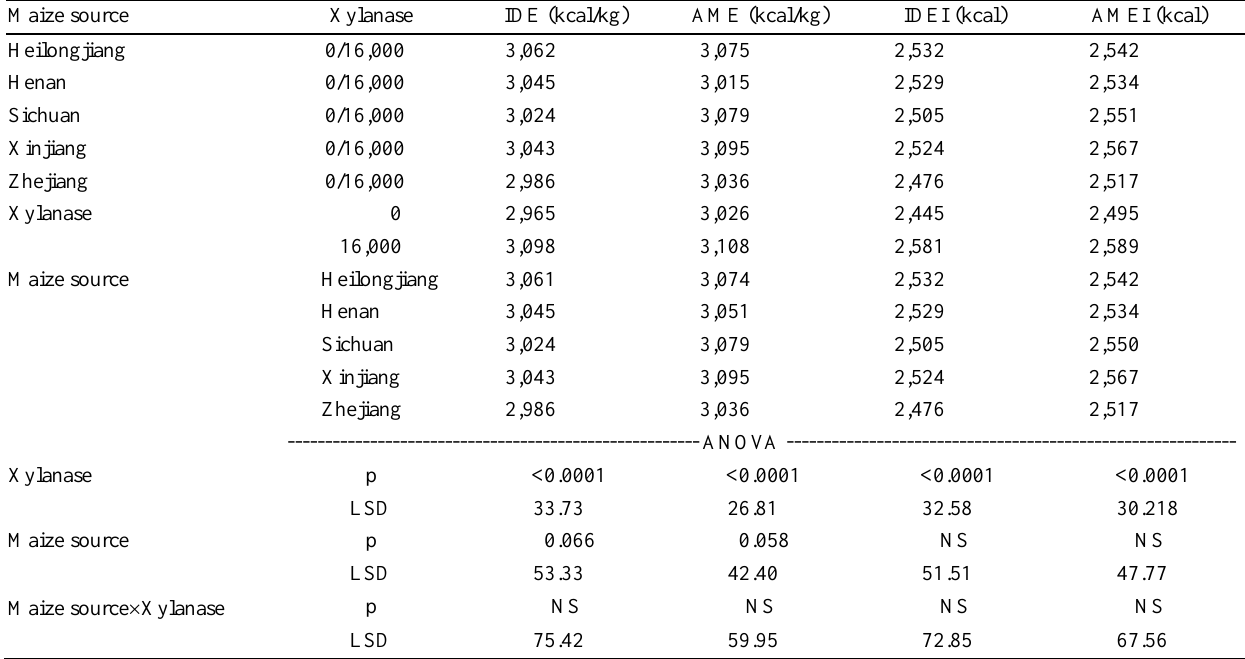
Table 6. Analysis of variance of the effect of maize source and xylanase dose on IDE, AME, IDE intake and AME intake Maize source